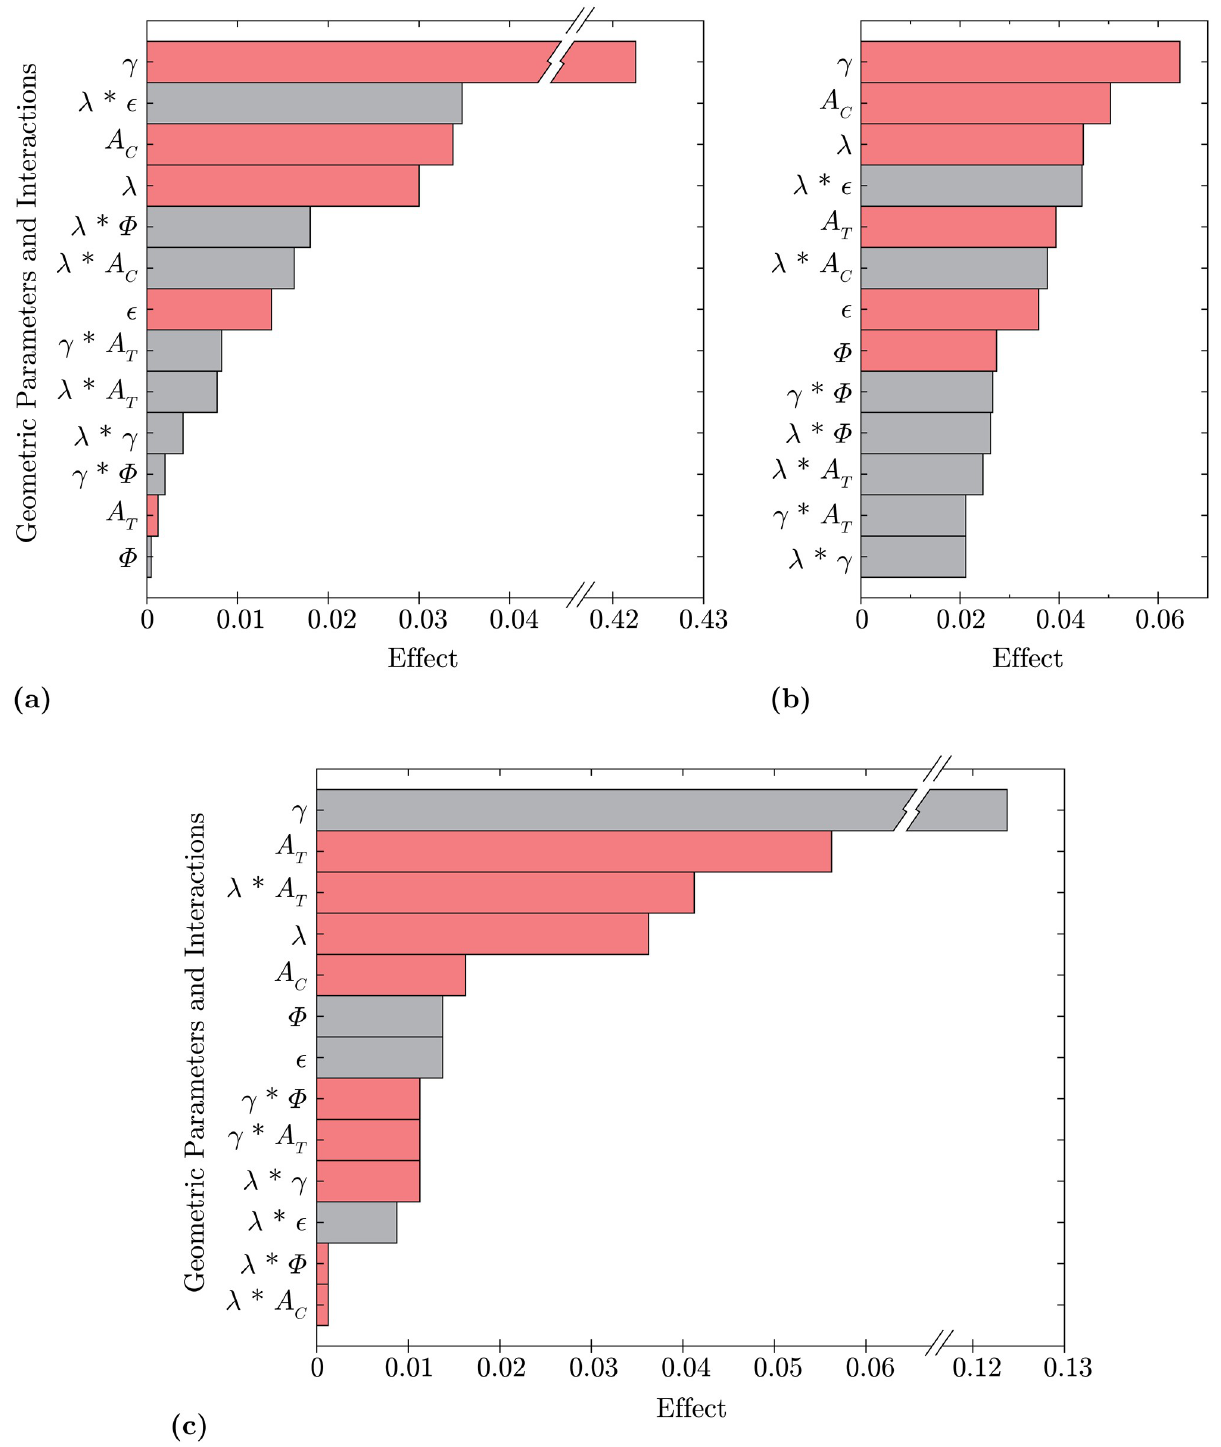
Fig 6. Pareto charts of effects. Three Pareto charts summarize the effects of modifications to geometric parameters on each of the response variables. Gray shaded regions indicate a positive correlation and the red shaded regions indicate a negative correlation. γ , A largest effects. (a) C Response (b) C L , RMS Response (c) St Response. D